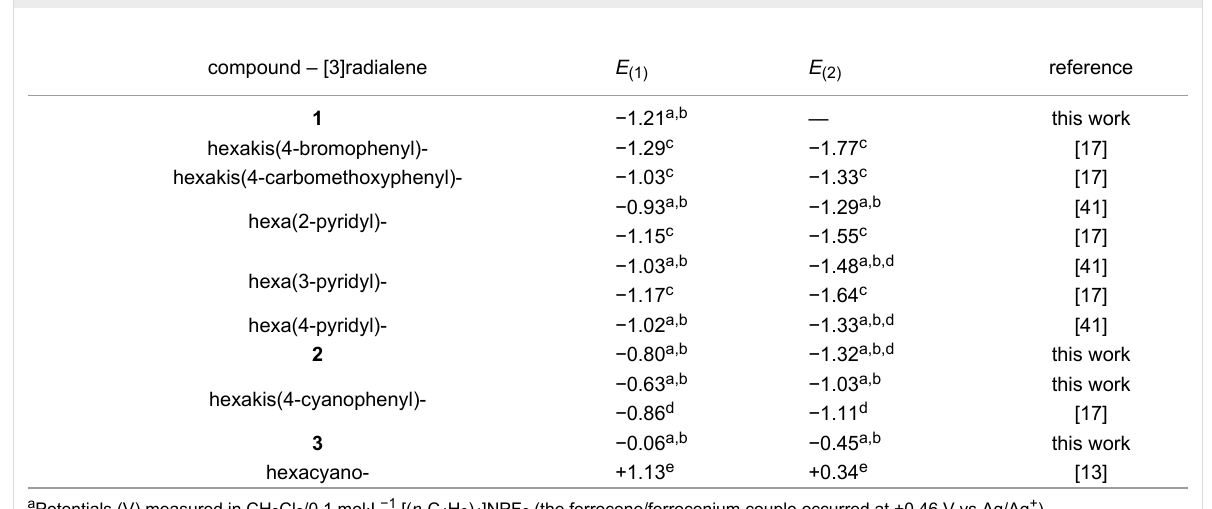
Table 1: Electrochemical potentials for the synthesised [3]radialenes 1 – 3 and related compounds.